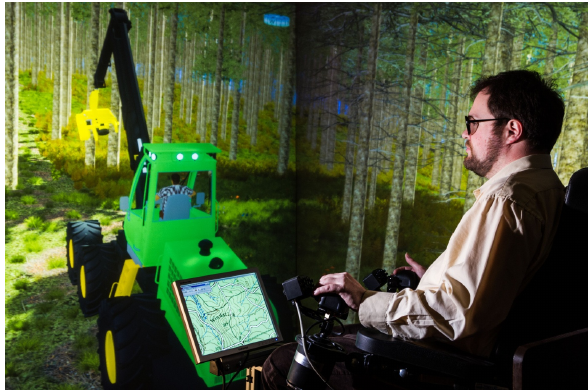
Figure 1. A driver training with the forest machine